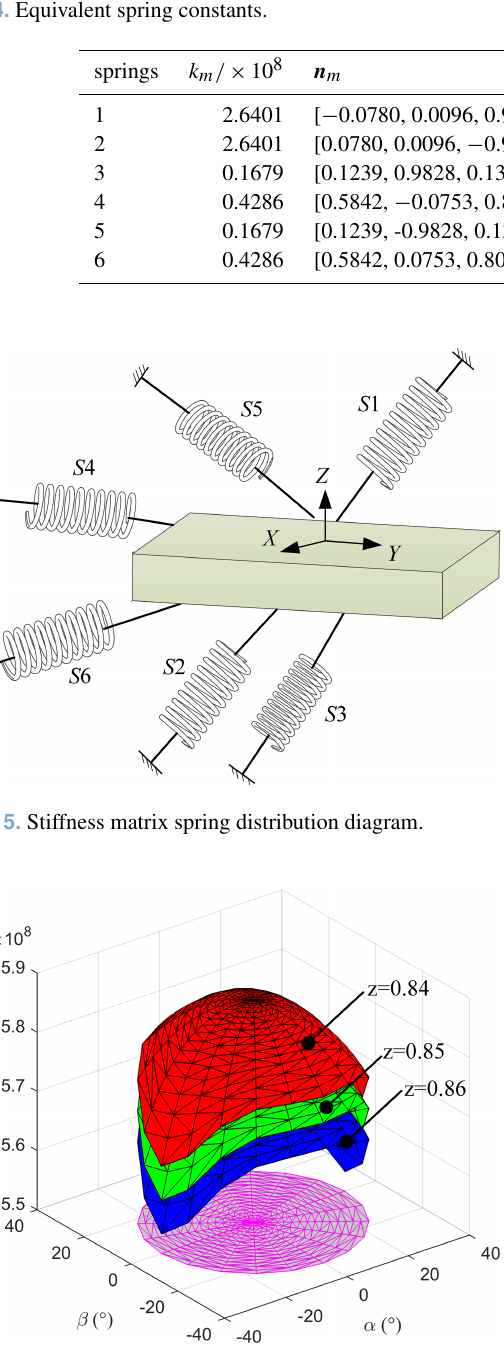
Figure 6. Parallel mechanism stiffness